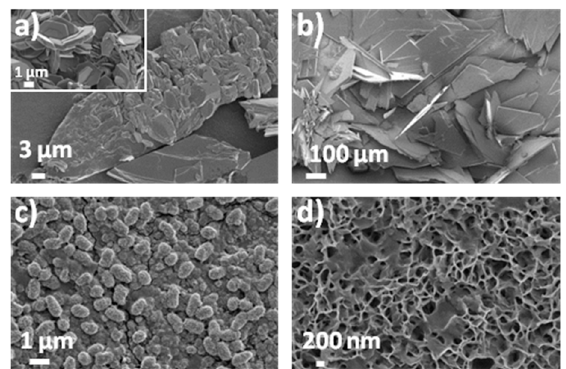
Figure 14. ( a , b ) FESEM images showing the formation of calcium phosphates precipitates and encrustations after immersion of PP support into artificial urine for 21 days. ( c , d ) Globular-shaped and spongelike morphology of hydroxyapatite